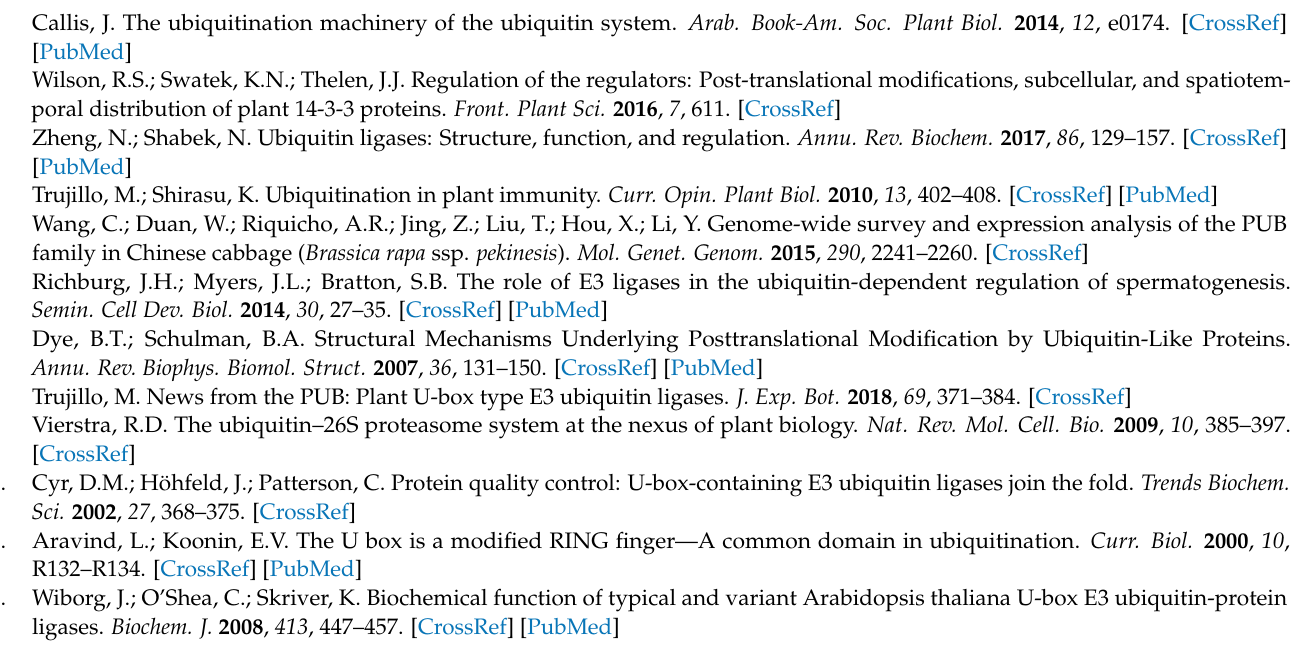
quences, Table S2: Analysis of conserved motifs in PgPUBs, Table S3: Ka-Ks calculation of each dupli- cated pair of U-box genes, Table S4: List TPM values of U-box gene in pomegranate different